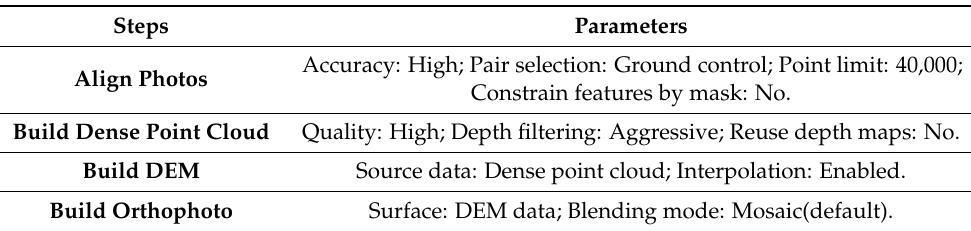
Table 3. Main parameters used in Agisoft Photoscan 1.4.2. under different steps of image processing to create orthophotos from each set of flight